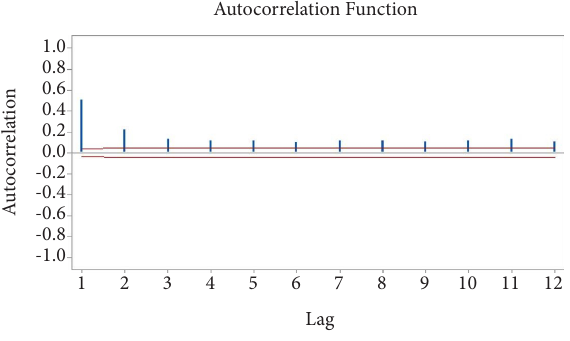
Figure 1: Autocorrelation function of wind speed.